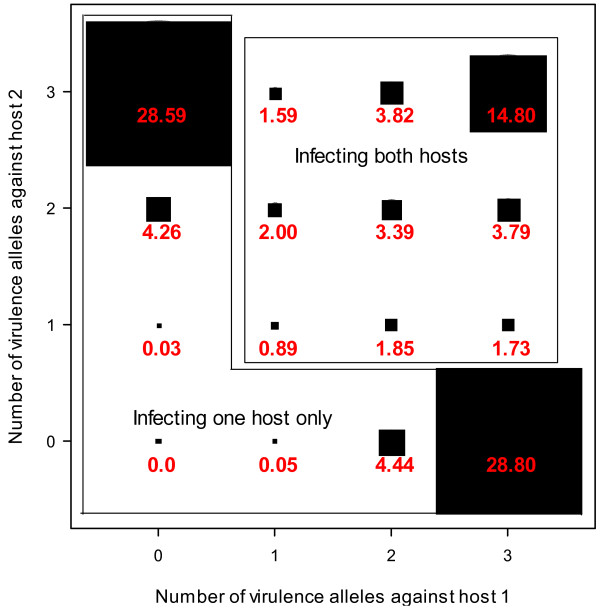
Bubble plot of the percentage of simulations with the specified composition of virulence alleles in the final fungal propagule at fixation over all simulation runs.